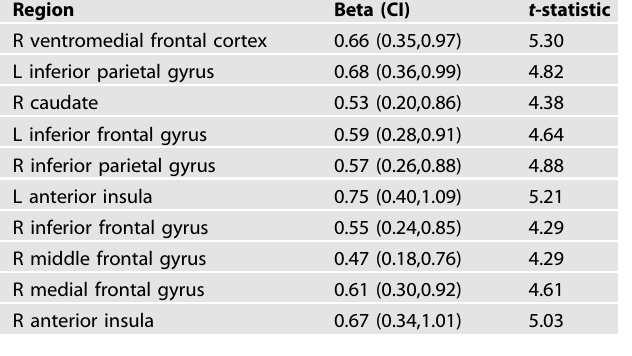
Table 3. The association of K d and dif fi cult control (SSSD > Go) in the clusters for Stop control (Stop >